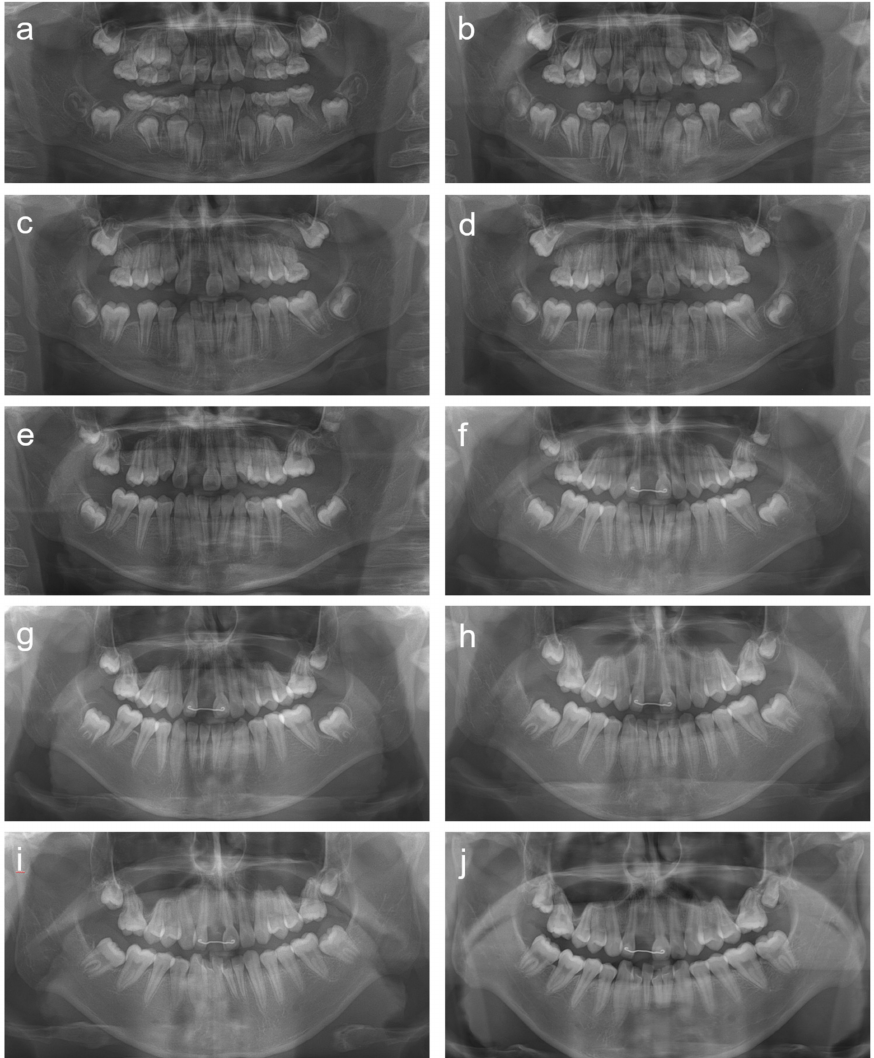
Figure 4. Panoramic radiographs of patient